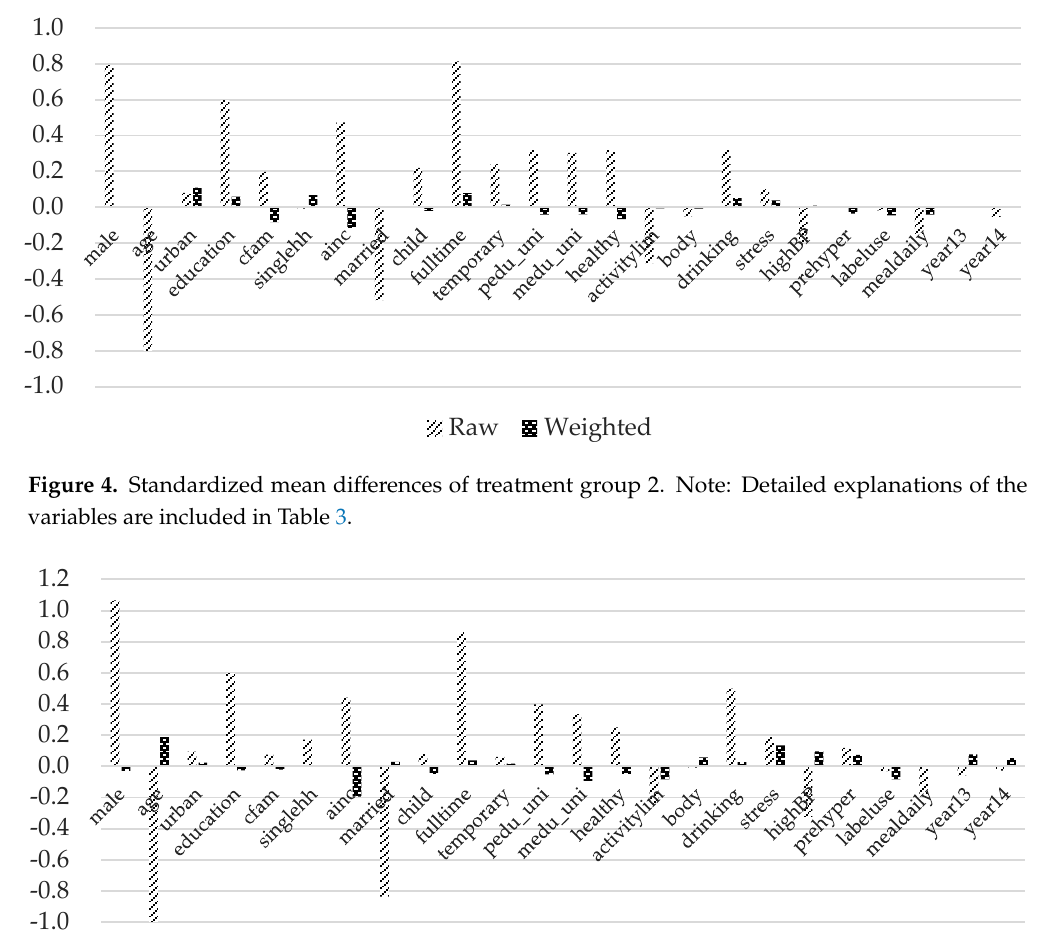
Figure 3. Standardized mean differences of treatment group 1. Note: Detailed explanations of the variables are included in Table 3.